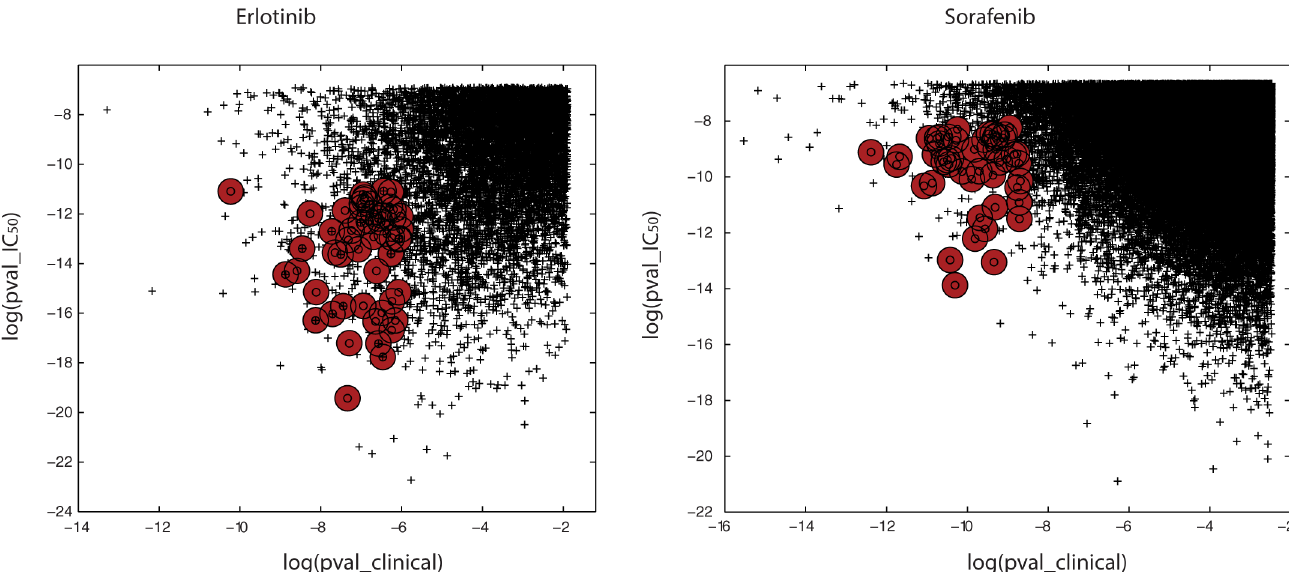
Fig 1. Erlotinib (left panel) and sorafenib (right panel) for log(pval_clinical) of the Pearsoncorrelation coefficient for each training model’s prediction of the clinical response(x-axis)versus the log(pval_IC 50 ) for the correlation coefficient of each model’s prediction of IC 50 versus the mean of each gene’s expression in the training model (y-axis). These results represent 20 million randompicks of 30 tumor cells and 300 genes from the CGP databaseof IC 50 values for erlotiniband sorafenib. For erlotinib,only 53 simulations achievedthe arbitrary thresholdrequirements of log(pval_IC 50 ) < -11, log(pval_clinical) < -6, ppv clinical < 0.45 and npv clinical < 0.45 and. These models appearas the red circles in the left panel.For sorafenibonly 48 simulations achievedthe thresholdrequirements of log(pval_IC 50 ) < -8.5, log(pval_clinical) < -8.5, ppv clinical < 0.65 and npv clinical < 0.65). Ppv and npv calculations requireselection of a boundarybetweengood and poor responses. These calculations use the mean of the predictive values as this boundary. Evident from this figure is the occurrence of trainingmodels with excellentcorrelative statistics that fail to meet the thresholds for ppv and